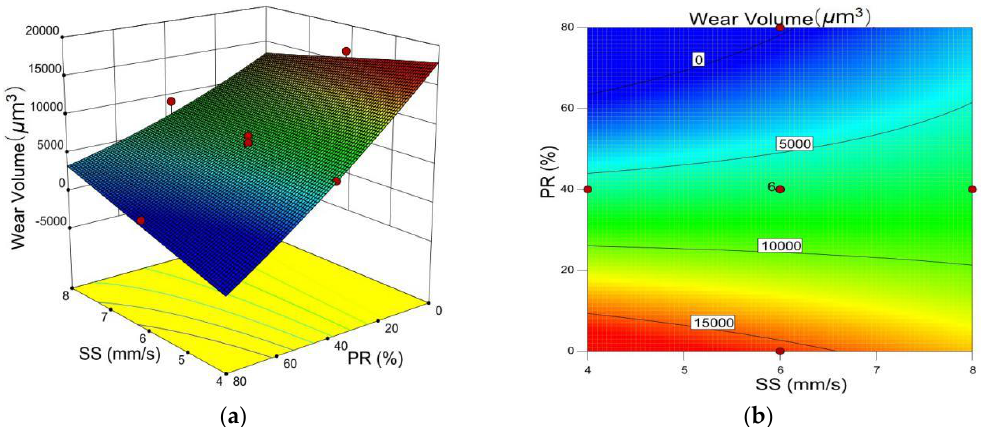
Figure 12. ( a ) 3D influence of scanning speed and the TiC powder ratio on wear volume. ( b ) Contour line of scanning speed and TiC powder ratio on wear volume.